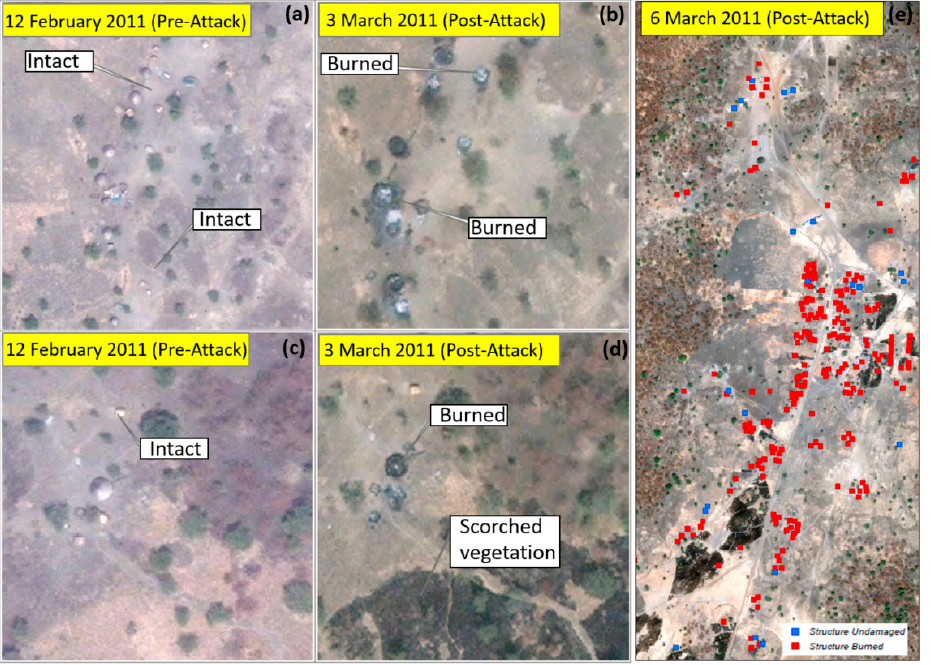
Figure 8. Satellite images of conflict zones in Sudan showing evidence of arson attacks: ( a ) and ( c ) pre-conflict images of 12 February, 2011 showing intact buildings ( b ) and ( d ) are post-conflict images on 3 March, 2011 showing burned structures in the Maker Awat region. ( e ) show the damaged and non-damaged structures of Tajalei region mapped from Worldview 2 imagery on 6 March, 2011. [Source: UNITAR/UNOSAT].